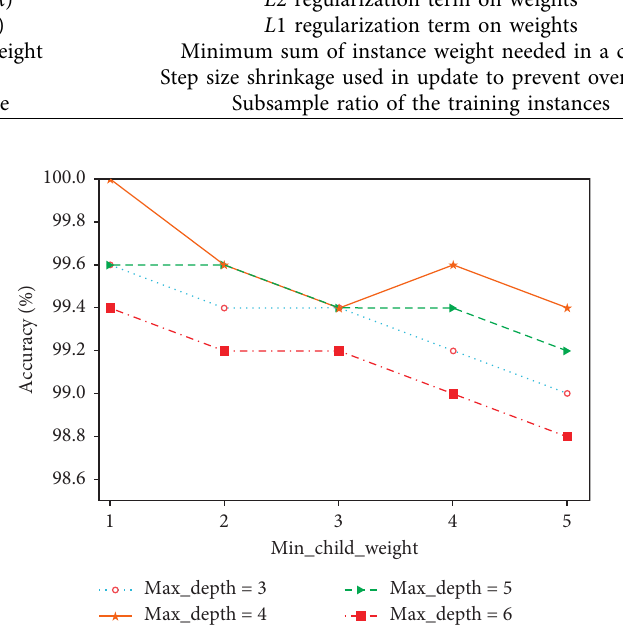
Figure 16: The influence of max_depth and min_child_weight on diagnosis